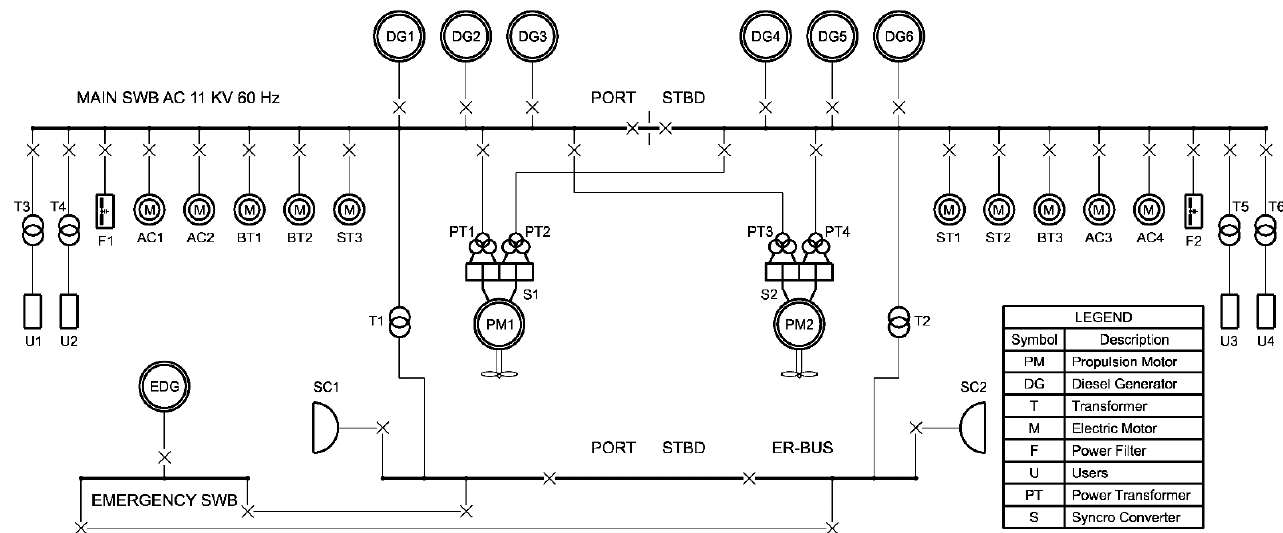
Figure 3. Shipboard power system layout.